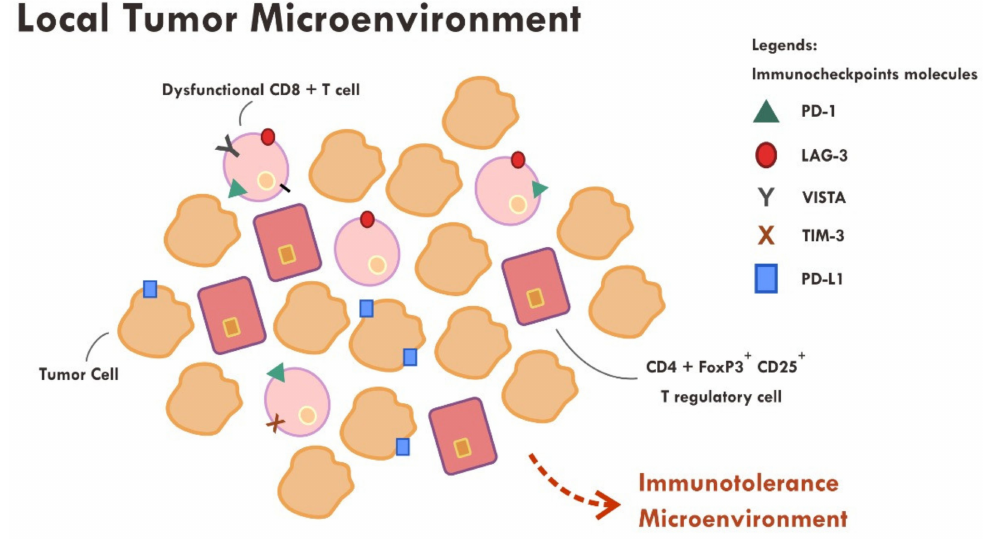
Figure 3. Abundance of dysfunctional CD8 + T cells expressing various immune inhibitory molecules (PD-1, LAG-3, VISTA, TIM-3, PD-L1) within the tumor microenvironment resulted in failure of tumor